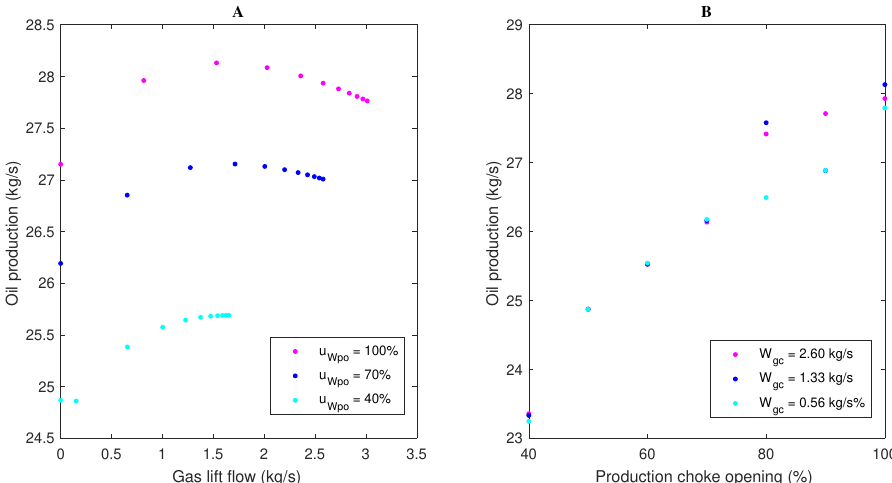
Figure 4. Steady state profile of w po : changes in ( A ) gas lift flow; and ( B ) production choke valve opening—Ribeiro’s